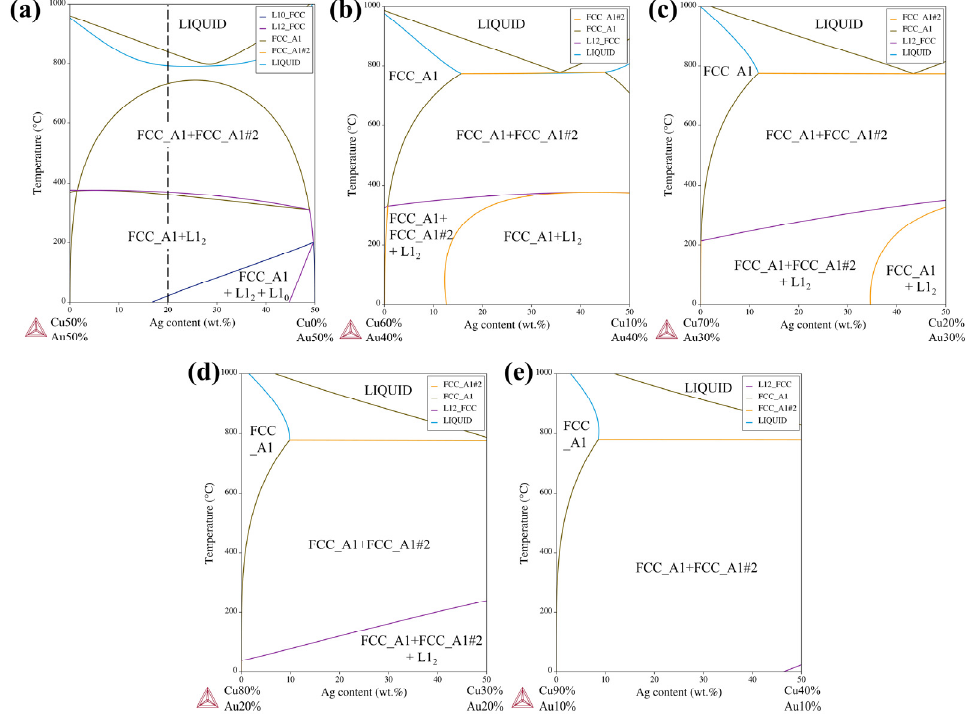
Figure 9. The Ag-Cu pseudo-binary phase diagrams. ( a ) 50 wt. % Au; ( b ) 40 wt. % Au; ( c ) 30 wt. % Au; ( d ) 20 wt. % Au; ( e ) 10 wt. % Au.